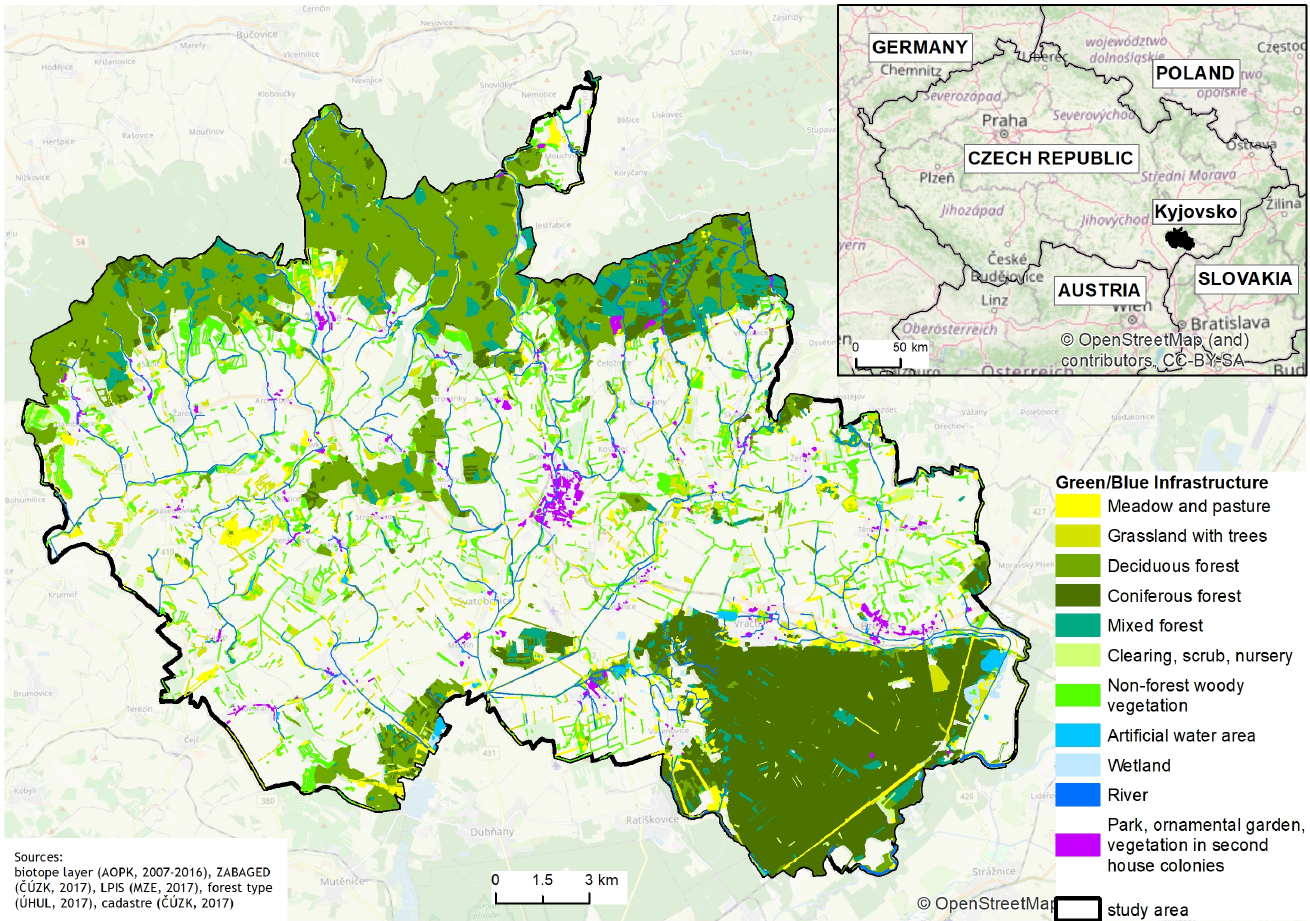
Figure 2: Green infrastructure in the case study region Kyjovsko in the Czech